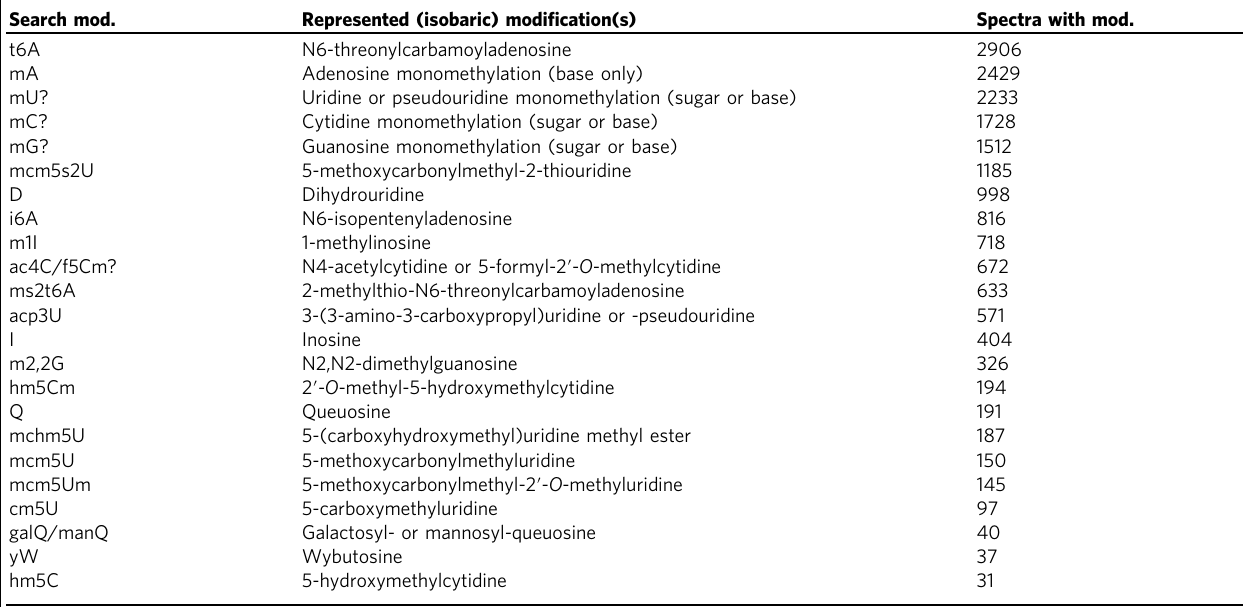
Table columns: 1. Short code of the modi fi cation speci fi ed as a search parameter. 2. The set of modi fi cations implied by the corresponding mass shift, since e.g. positional isomers (Cm, m3C, m5C etc.) generally cannot be distinguished.A question mark in the short code (column 1) indicates that modi fi cationof the ribose or the base (implyingdifferent massesof “ a-B ” ions)should both be considered. Forms that are not expected to occur in human tRNA (e.g. Am, Im) are not listed. 3. Number of times identi fi ed as part of an oligonucleotide-spectrum